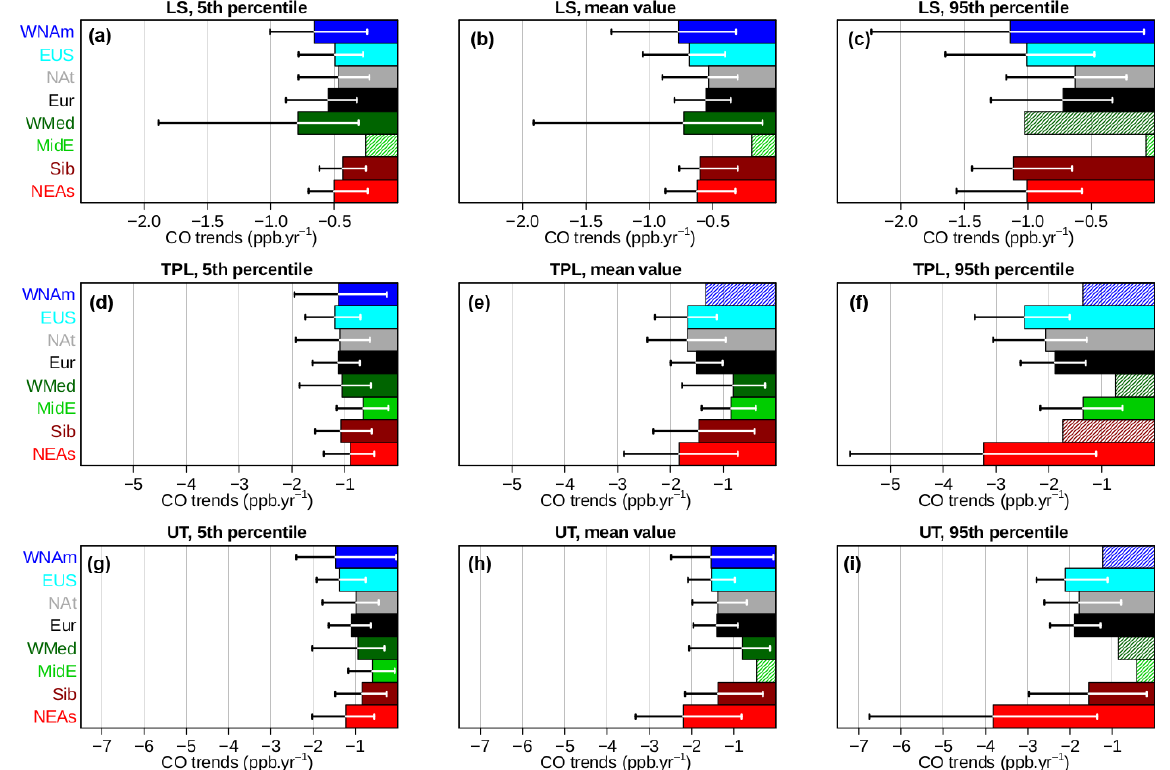
Figure 13. CO trends (ppbyr − 1 ) in the UT, TPL, and LS (from bottom to top) for the monthly 5th percentile (a, d, g) , mean value (b, e, h) , and 95th percentile (c, f, i) . For each significant trend, the error bars represent the 95% confidence interval. The insignificant trends are represented by hatched areas. The coloured labels correspond to the regions defined in Fig. 1.